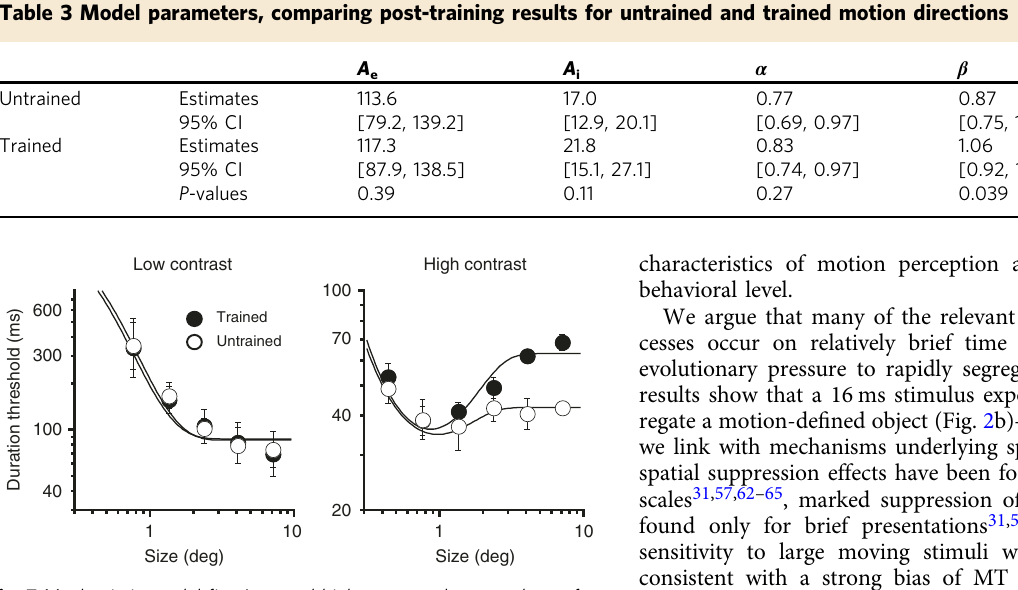
Fig. 7 Mechanistic model fi ts. Low and high contrast data are shown for observers that exhibited signi fi cant perceptual learning, contrasting the trained and the untrained motion direction. Lines are mechanistic model fi ts as described in the main text and “ Methods ” section. All error bars are